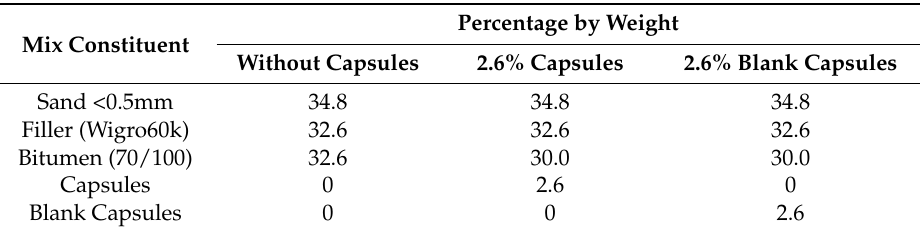
Table 1. Mix composition of asphalt mortar.